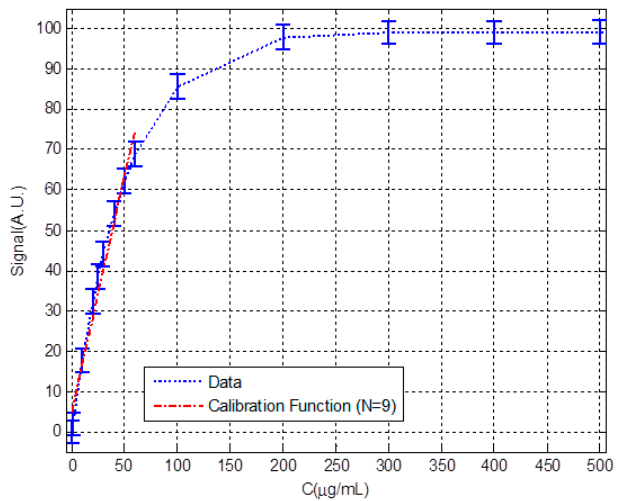
Figure 5. Theoretical sets of points representing an immunoassay and calibration function build for the first nine points. Table 1. Numerical values represented in Figure 5.